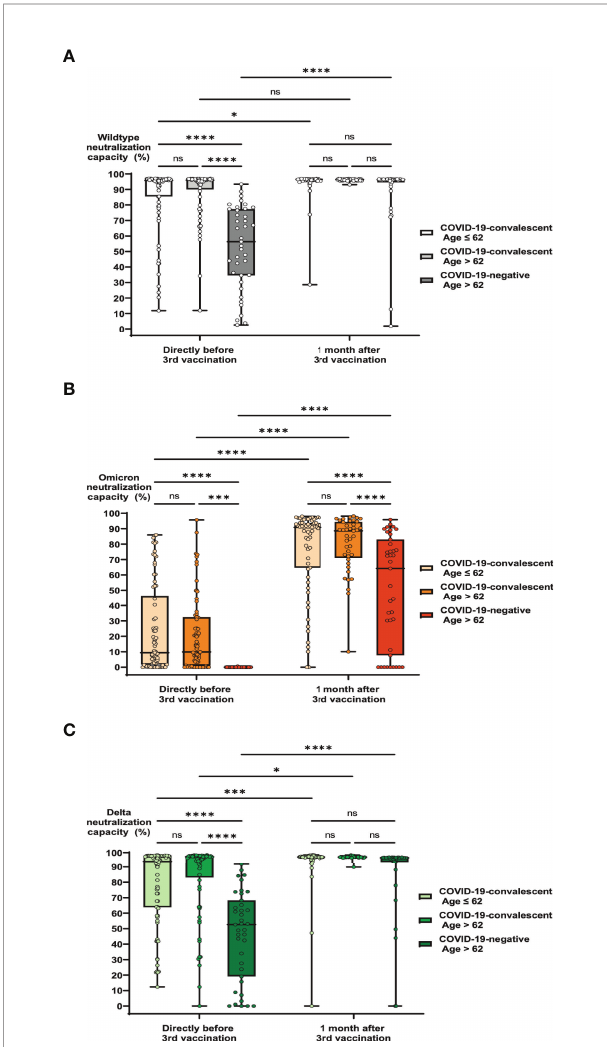
FIGURE 4 | Impact of age and previous SARS-CoV-2 infection on neutralization capacities against variants of concern before and after booster vaccination. Serum samples from 73 COVID-19-convalescent individuals under the age of 63, 74 COVID-19-convalescent individuals above the age of 62 and 39 individuals above the age of 62, who never had a SARS-CoV-2 infection were collected directly before and one month after booster vaccination with BNT162b2. Samples were then analyzed for speci fi c neutralization capacities against wiltype SARS-CoV-2, B.1.1.529 (Omicron) and B.1.617.2 (Delta). Box blots show neutralization capacities in the three study cohorts against (A) wild type SARS-CoV-2, (B) B.1.1.529 and (C) B.1.617.2, before and after vaccination as indicated. Box central horizontal lines indicate medians, box borders represent IQR, whiskers indicate minima and maxima. Signi fi cance levels were *p < 0.05, ***p < 0.0005 and ****p < 0.00005. IQR: interquartile ranges, ns: not signi fi